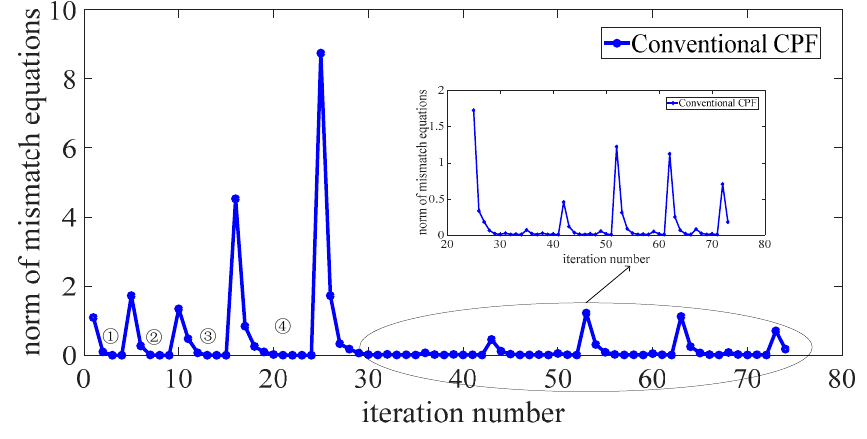
Figure 11. Conventional CPF corrector iteration at λ =